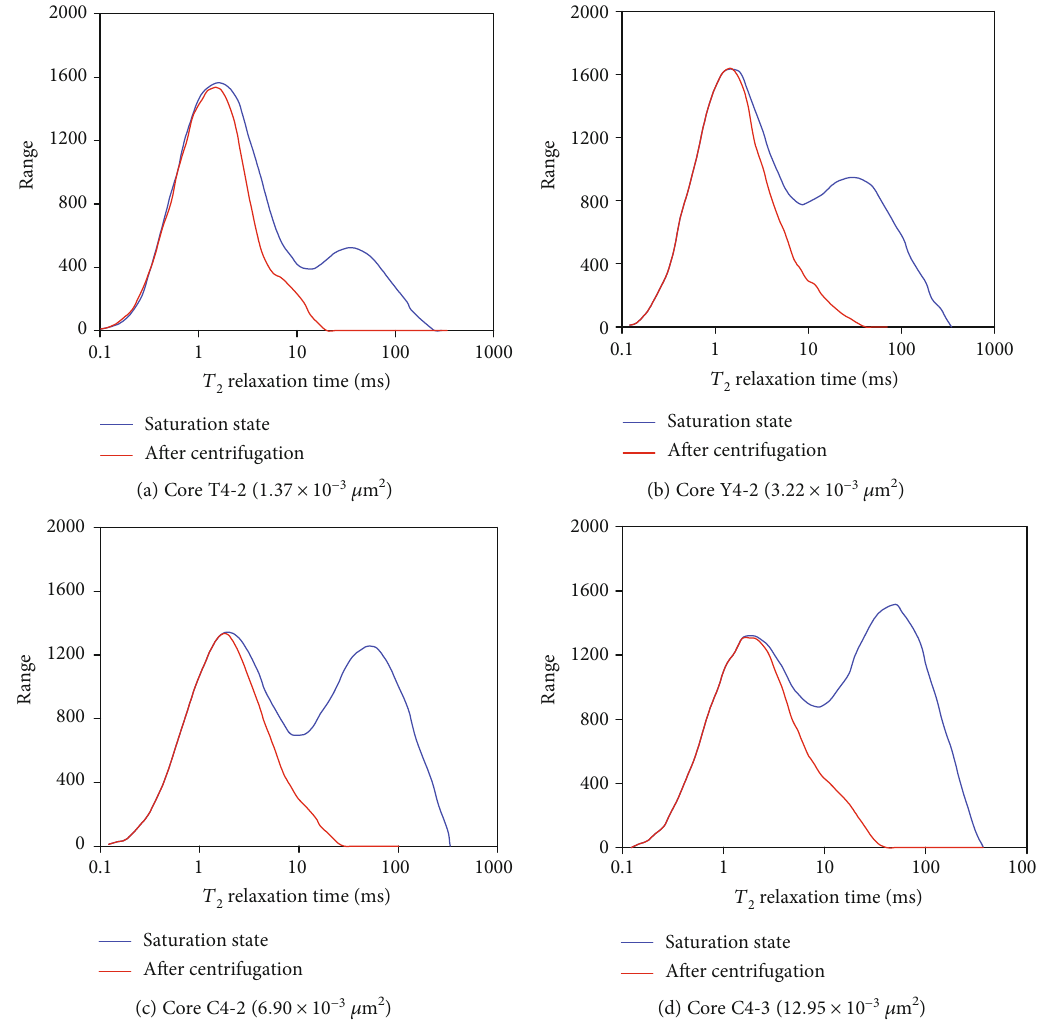
ff erent low-permeability cores.